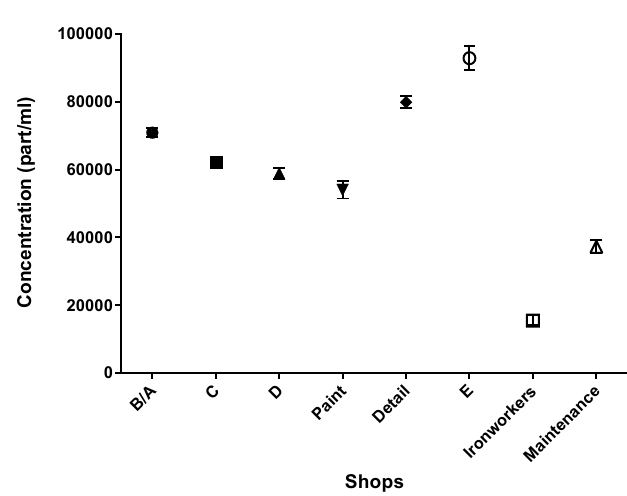
Figure 2. Geometric means (GM) and 95% confidence intervals of shop surveys; B/A ( n = 2200), C ( n = 2085), D ( n = 1435), paint ( n = 757), detail ( n = 2732), E ( n = 1205), ironworkers ( n = 538), and maintenance ( n = 630).